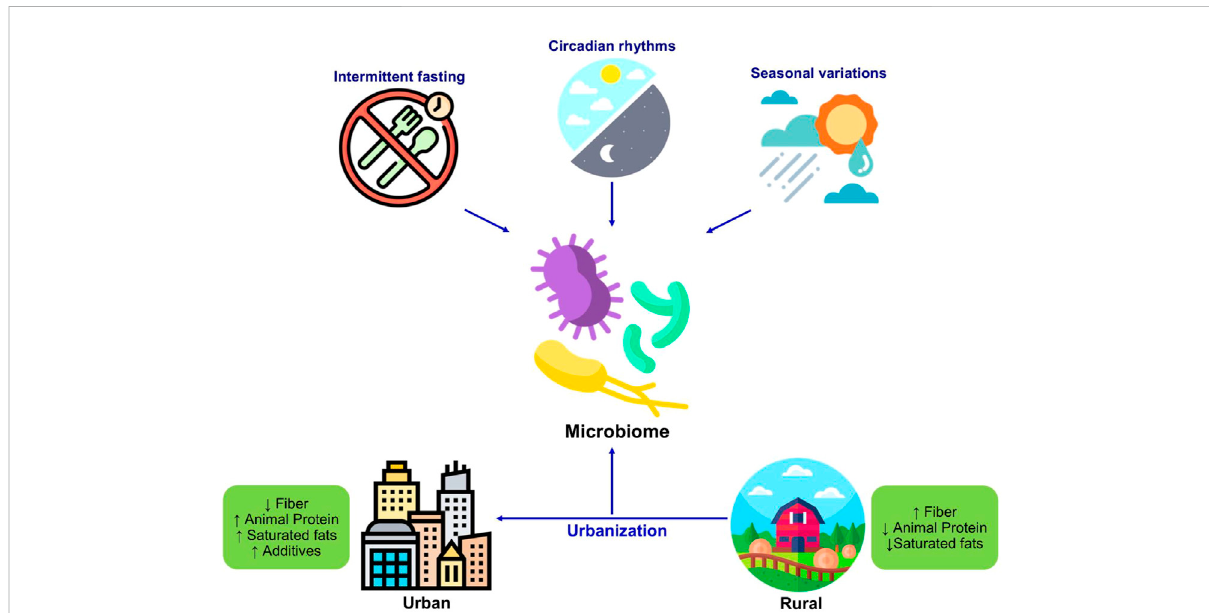
FIGURE 3 Changes in the microbiome in response to diet and lifestyle. The dietary habits including intermittent fasting seasonal variations, circadian rhythmicity shape the microbiome composition. The westernization resulted in changes in dietary patterns and dietary components which signi fi cantly changes the gut microbiome composition as well as